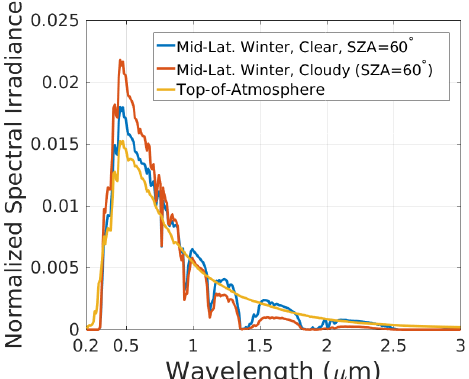
Figure 1. Normalized spectral irradiances for select environments. Values represent the fraction of total 0.2–5.0µm surface irradiance within each 10nm band used as weights to determine broadband albedo. Top-of-atmosphere spectral irradiances at wavelengths out- side those depicted constitute less than 1% of total